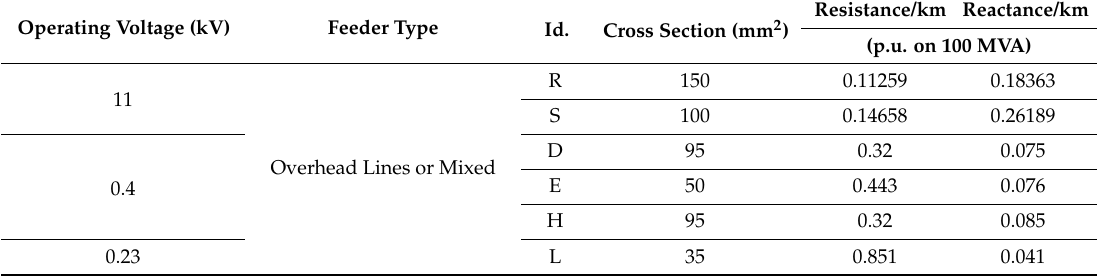
Table 2. Parameters of Typical MV/LV Transformers